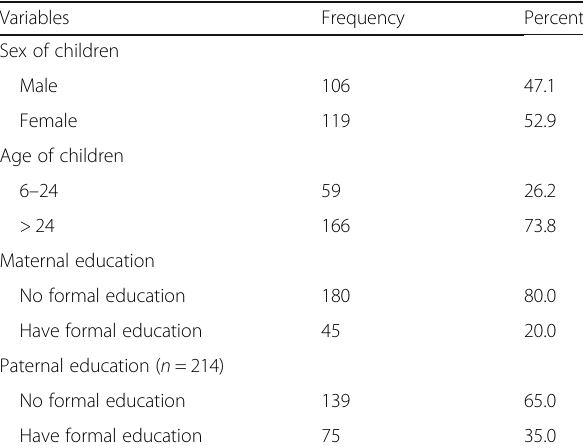
Table 1 Socio-demographic information of households with children aged 6 – 59 months in rural Dembiya, northwest